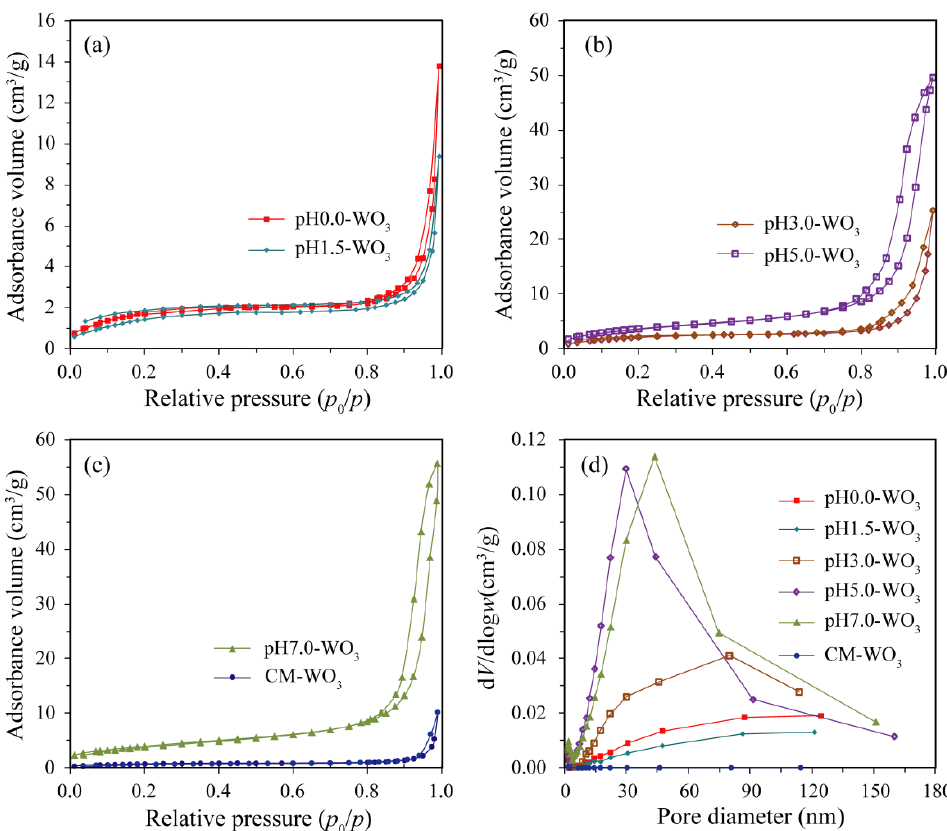
Figure 6. Nitrogen adsorption – desorption isotherm of ( a ) pH0.0-WO 3 and pH1.5-WO 3 , ( b ) pH3.0-WO 3 and pH5.0-WO 3 , ( c ) pH7.0-WO 3 and CM-WO 3 , and ( d ) the corresponding the pore size